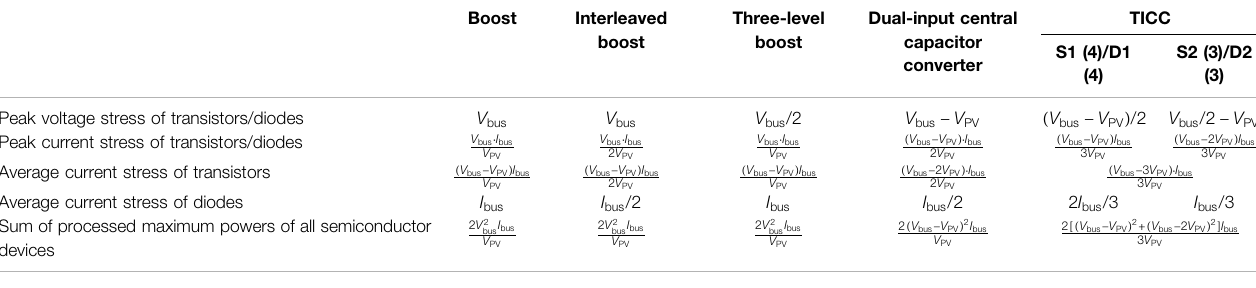
TABLE 3 | Comparison of semiconductor device stress.